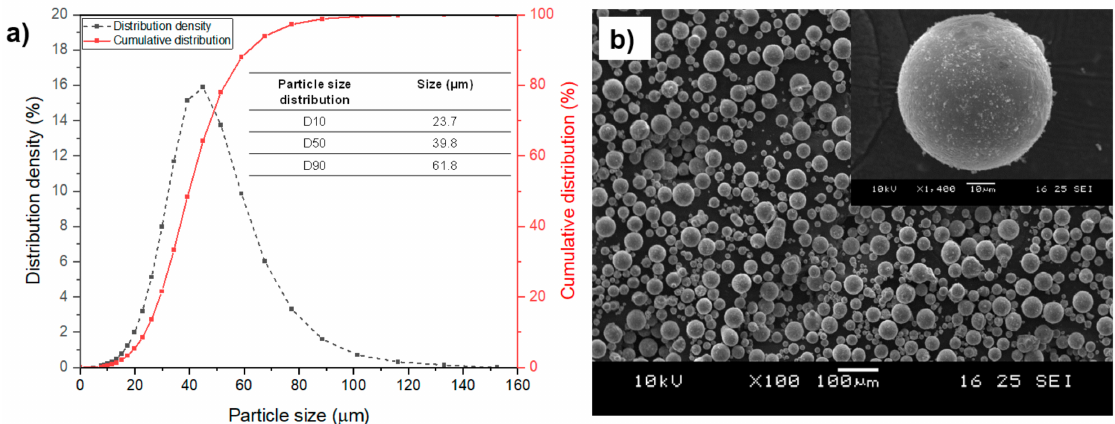
Figure 1. Characterization of the as-received AZ91 powder. ( a ) Particle size distribution obtained via laser light scattering and ( b ) SEM